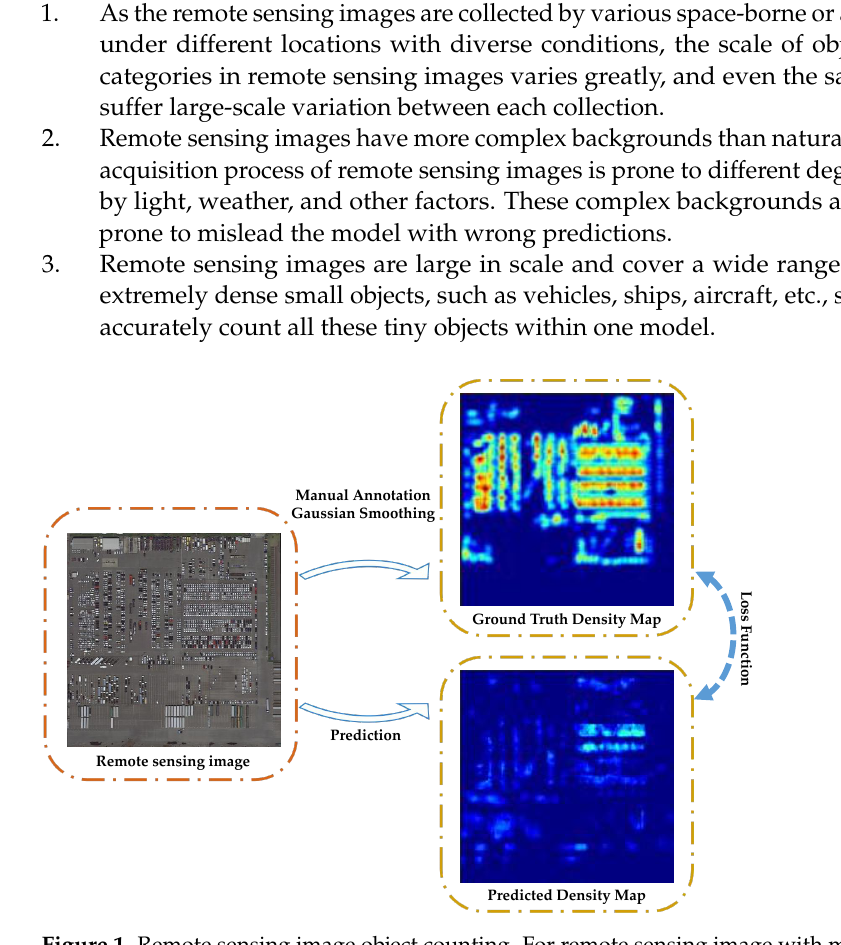
Figure 1. Remote sensing image object counting. For remote sensing image with manually annotated point label, the Gaussian smoothing on the dot map is used to generate corresponding density map. Different from natural images, remote sensing images suffer from large target scale variation and unbalanced target